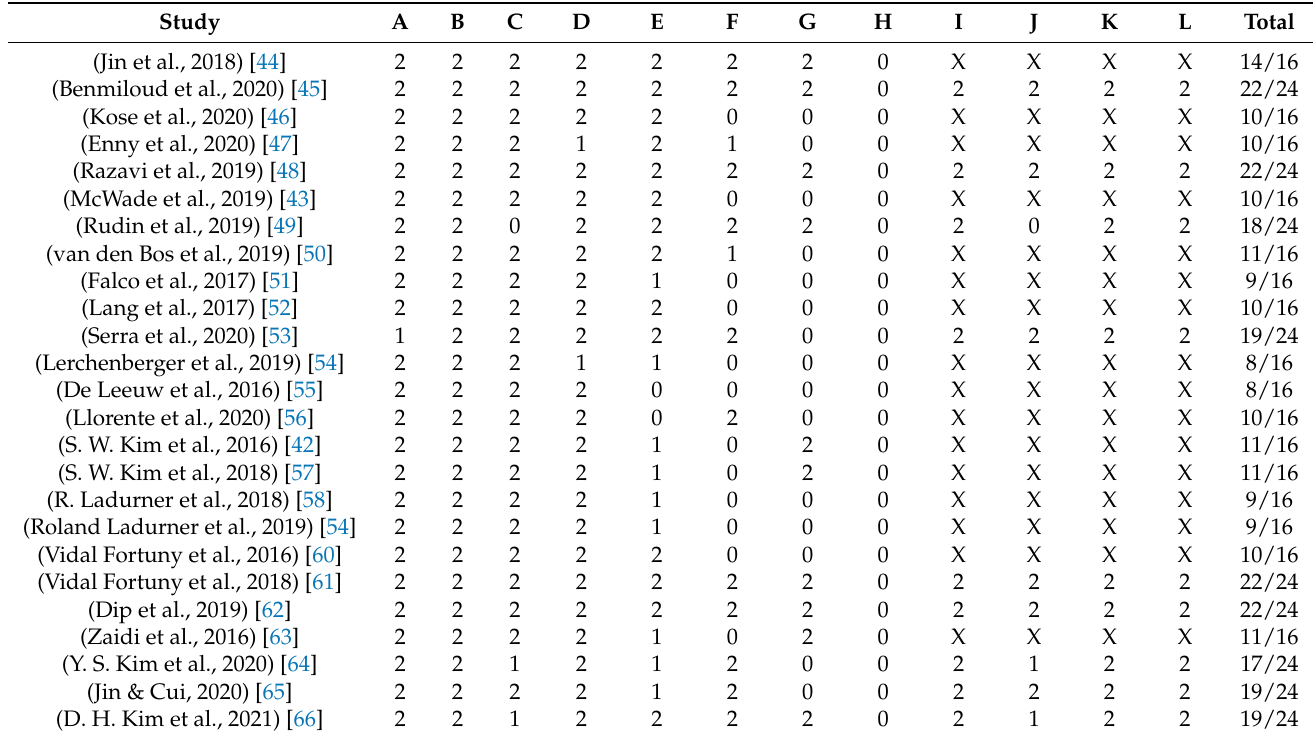
Table 2. Methodological Index for Non-Randomized